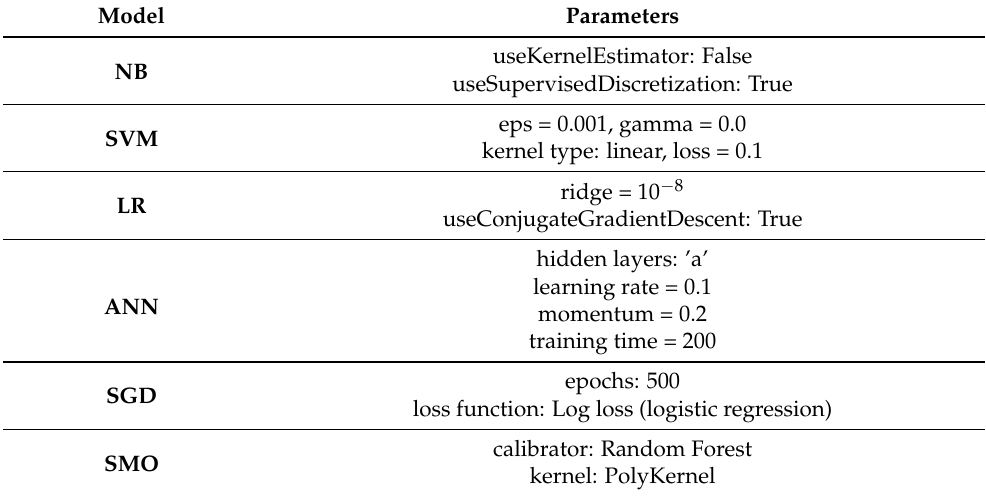
Table 4. Machine Learning Models’ Parameters